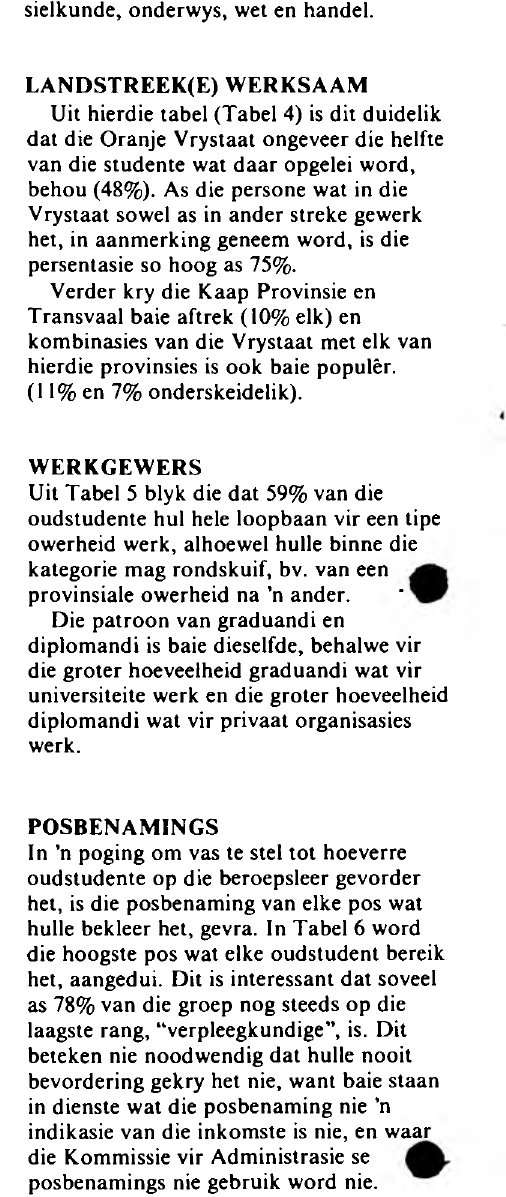
TABEL 4 . LANDSTREKE WAAR OUDSTIIDENTE CEWERK HET OF NOG WERK Graduandi